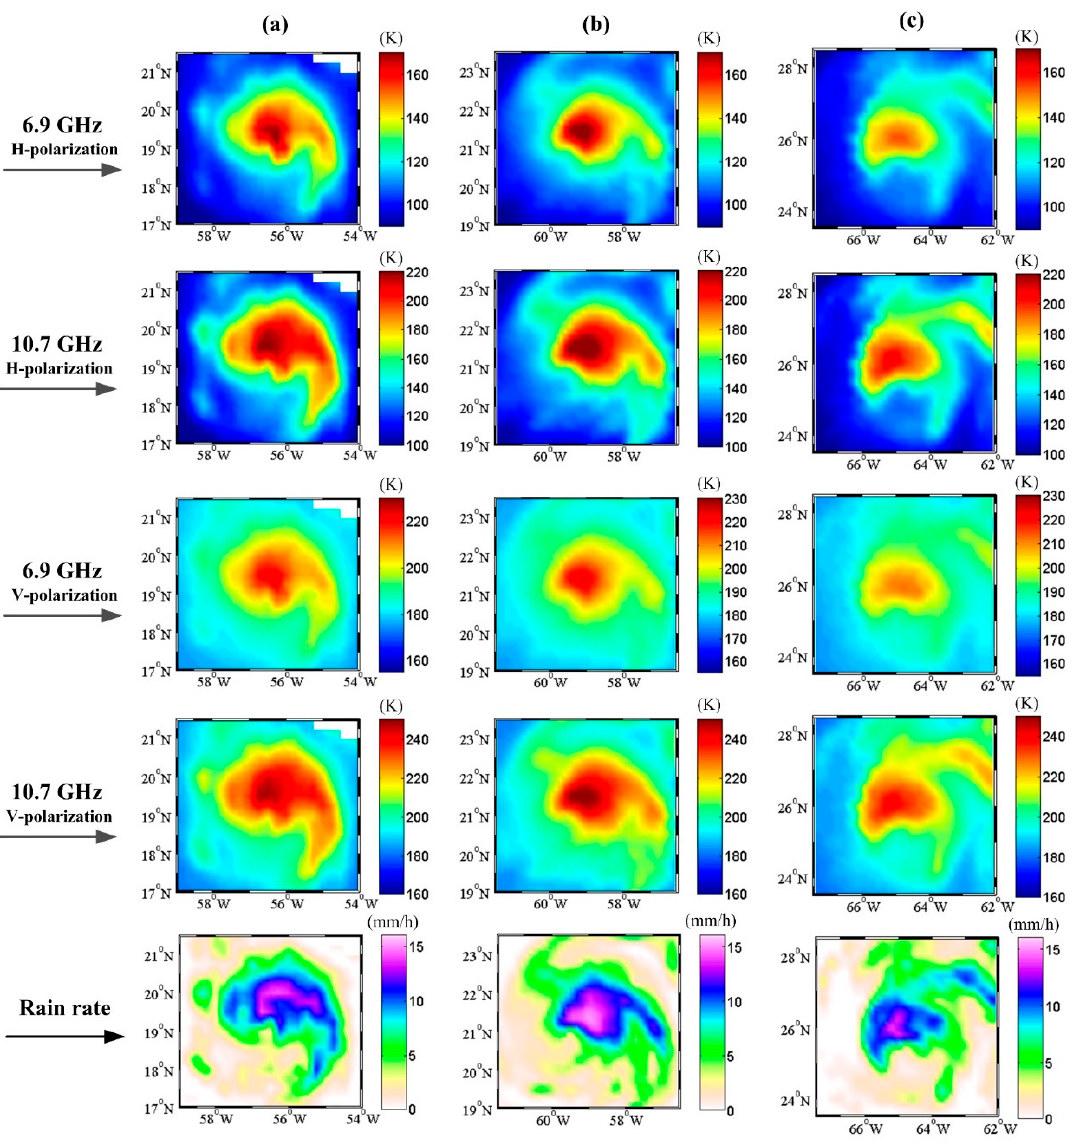
Figure 7. AMSR-E observed low-frequency channel brightness temperatures and rain rates over hurricane Bill on ( a ) 19 August 2009, at 1650 to 1654 UTC; ( b ) 20 August 2009, at 0512 to 0516 UTC; and ( c ) 21 August 2009, at 0555 to 0559 UTC.